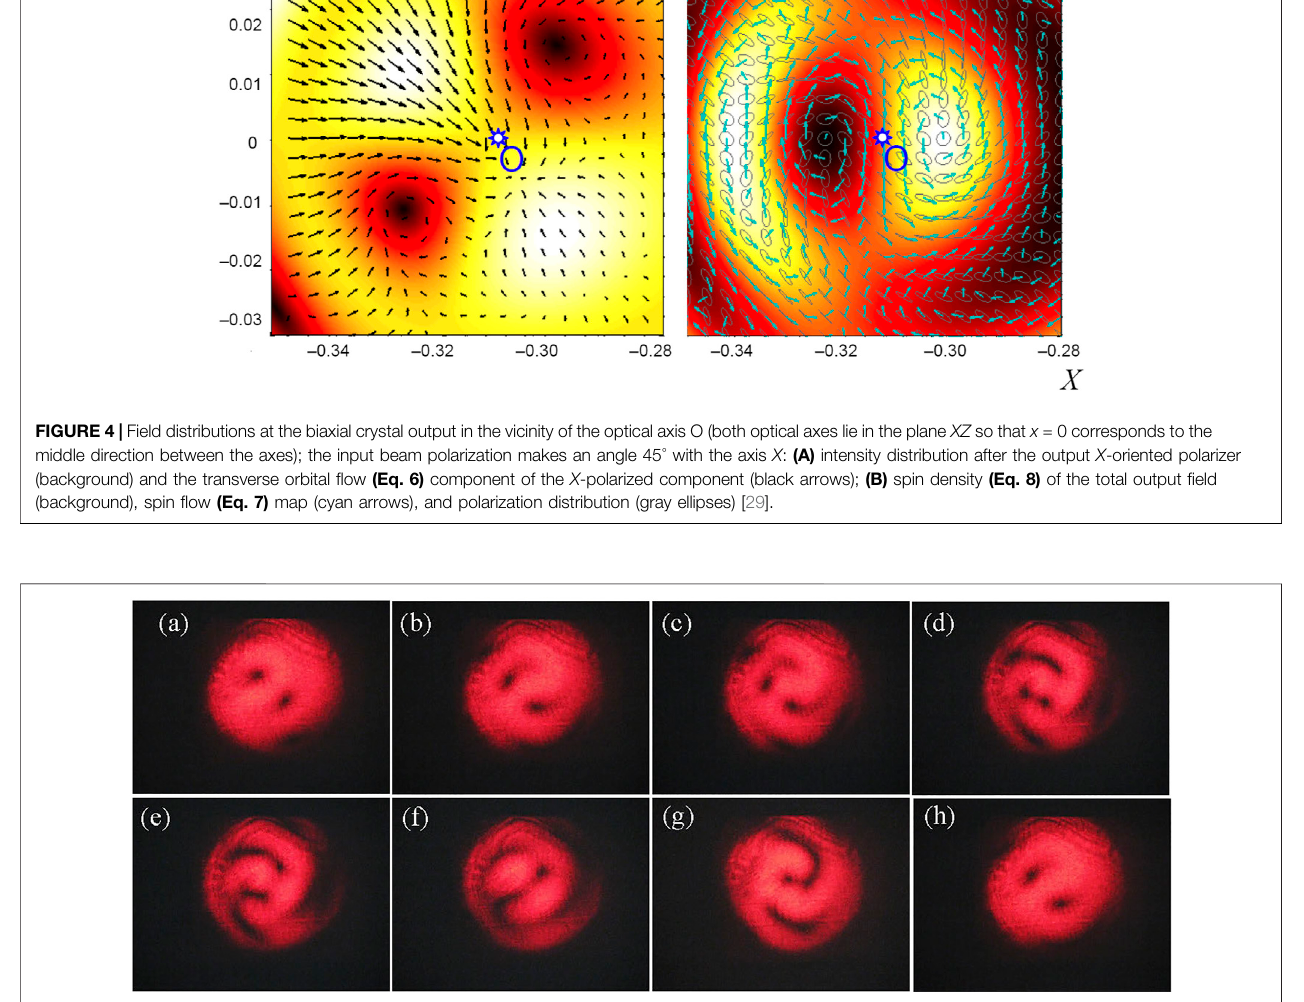
FIGURE 5 | Illustration of the different sorts of optical traps created by means of the birefringent crystal and their transformations in the arrangement of Figure 3 [29]. Images (a – h) represent the fi eld patterns realized by proper adjustment of the optical system (explanations in the text).